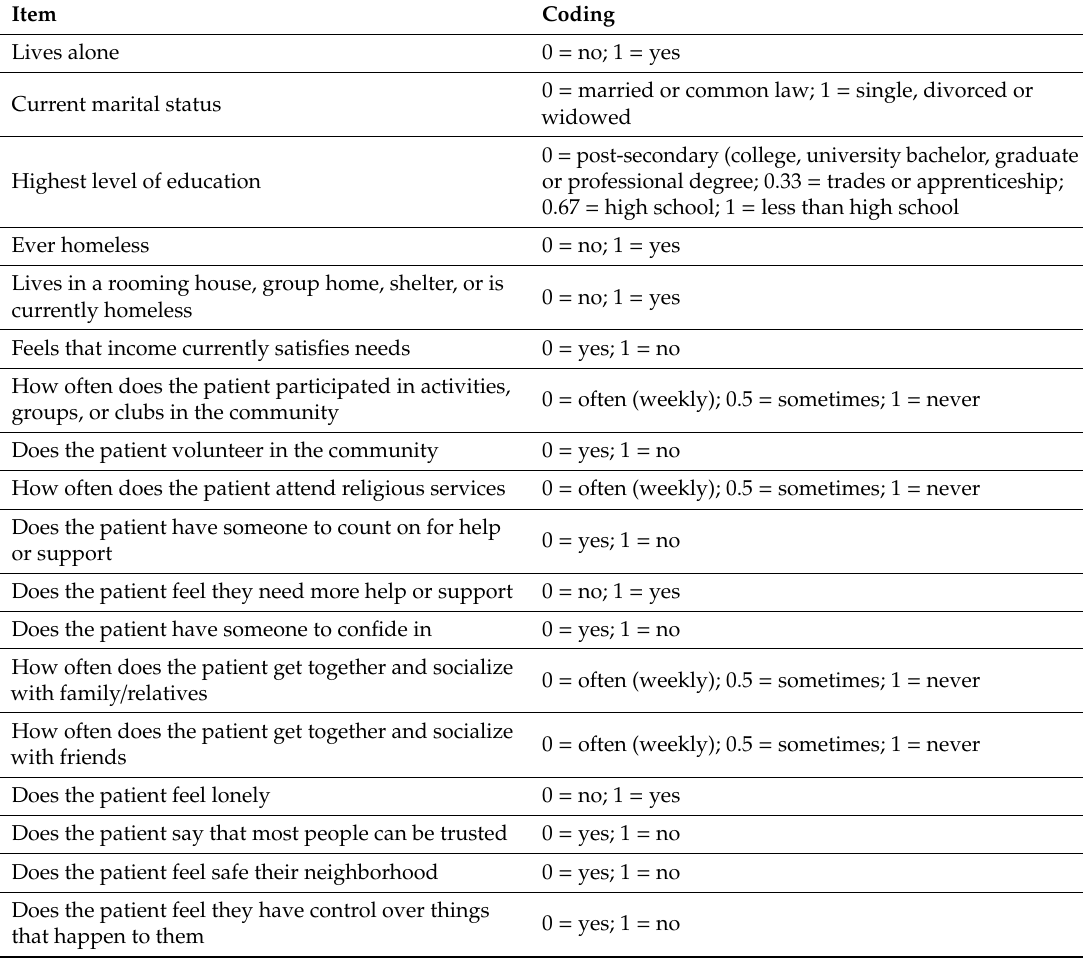
Table 1. Social vulnerability index (SVI) items and deficit